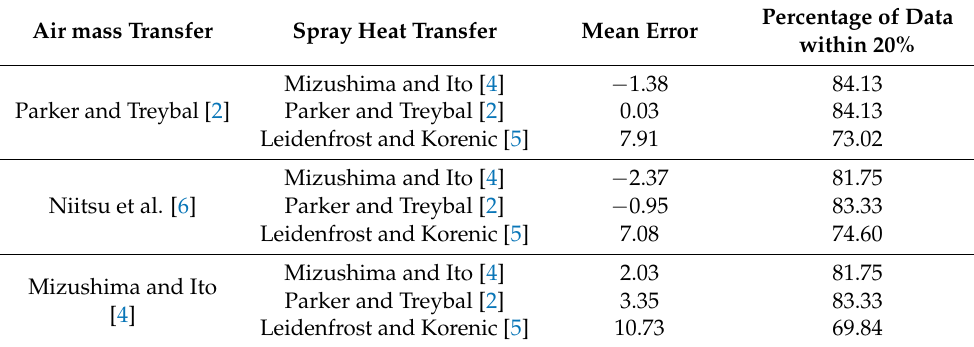
Table 4. Mean error and percentage of data points within the 20% margin error for the different